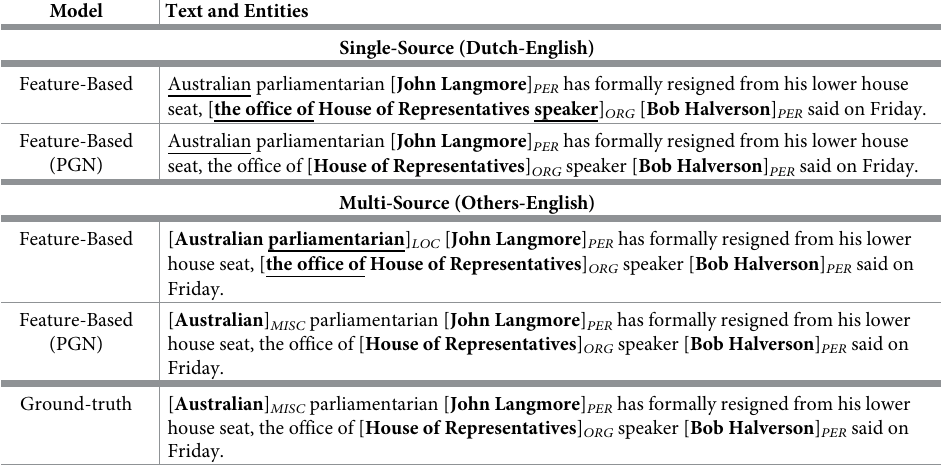
Table 6. A case study, where the text with underlines indicates